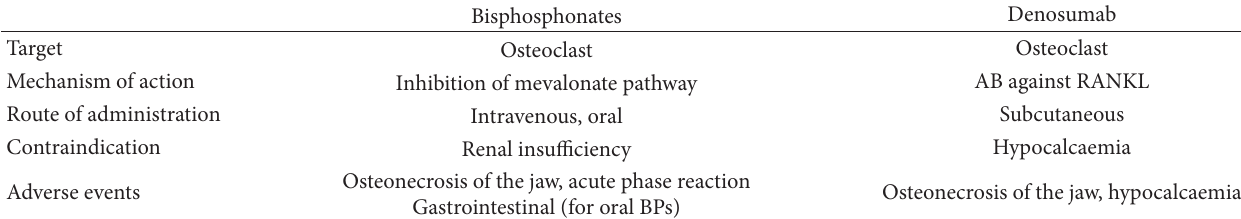
Table 1: Characteristics of antiresorptive agents used for patients with prostate